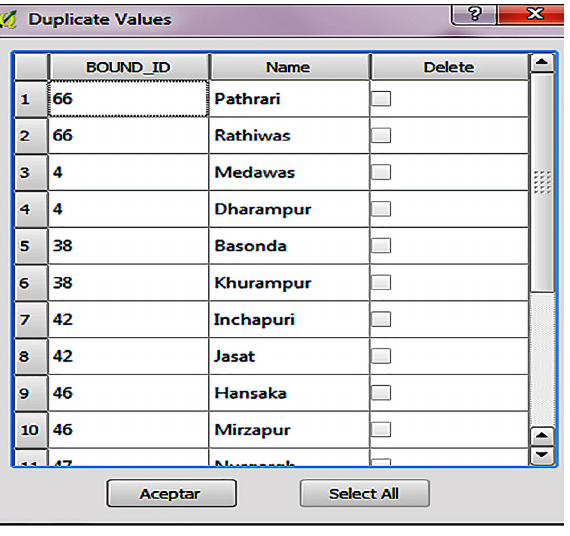
Fig. 10. User interaction with GeoWebCln tool.